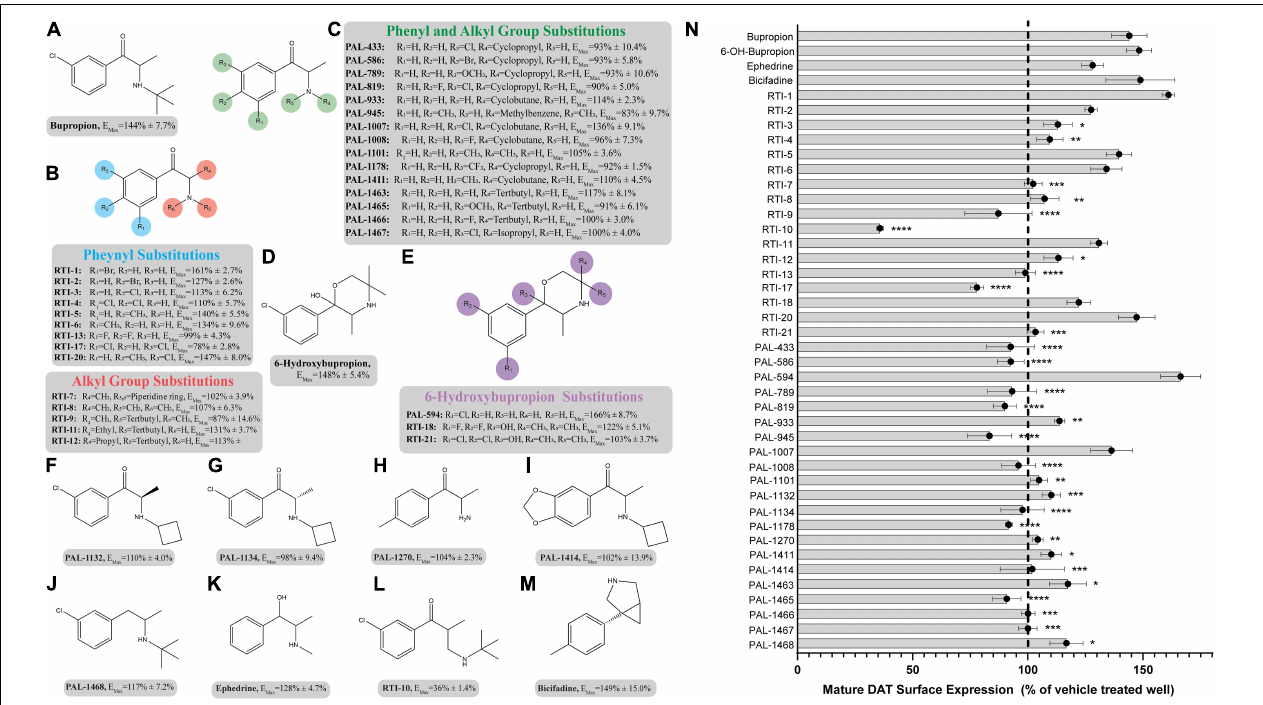
FIGURE 1 | Structures of bupropion analogs and their maximal effects (E Max ) on WT DAT surface expression. (A) Structure and E Max of bupropion. (B) Bupropion analogs with phenyl substitutions (blue) or alkyl group substitutions (red). E Max included for each compound. (C) Bupropion analogs with both phenyl and alkyl group substitutions. E Max included for each compound. (D) Structure and E Max of bupropion’s primary metabolite, 6-Hydroxybupropion. (E) 6-Hydroxybupropion analogs. E Max included for each compound. (F) Structure and E Max of bupropion analog PAL-1132. (G) Structure and E Max of bupropion analog PAL-1134. (H) Structure and E Max of bupropion analog PAL-1270. (I) Structure and E Max of bupropion analog PAL-1414. (J) Structure and E Max of bupropion analog PAL-1468. (K) Structure and E Max of bupropion analog ephedrine. (L) Structure and E Max of bupropion analog RTI-10. (M) Structure and E Max of bupropion analog bicifadine. (N) Bar graph of bupropion analogs E Max (**** p < 0.0001, *** p < 0.001, ** p < 0.01, and * p < 0.05, one-way ANOVA compared to bupropion with Dunnett’s test). Analogs are grouped in gray boxes based on similarities to the bupropion backbone. Data were normalized to vehicle